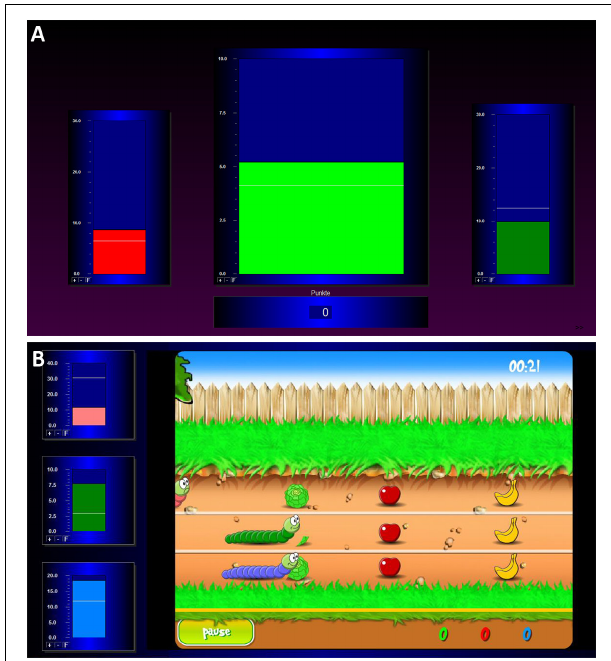
FIGURE 1 | Illustration of the two feedback screens for the NF training. (A) The classic training, consisting of three bars which represent the EOG amplitude (left bar; 4–7 Hz), the SMR amplitude (middle bar; 12–15 Hz), and the muscle artifacts amplitude (right bar; 21–35 Hz). (B) The worm race, consisting of a racetrack and three worms reflecting the EOG, SMR, and muscle artifacts amplitudes on the left side of the screen.